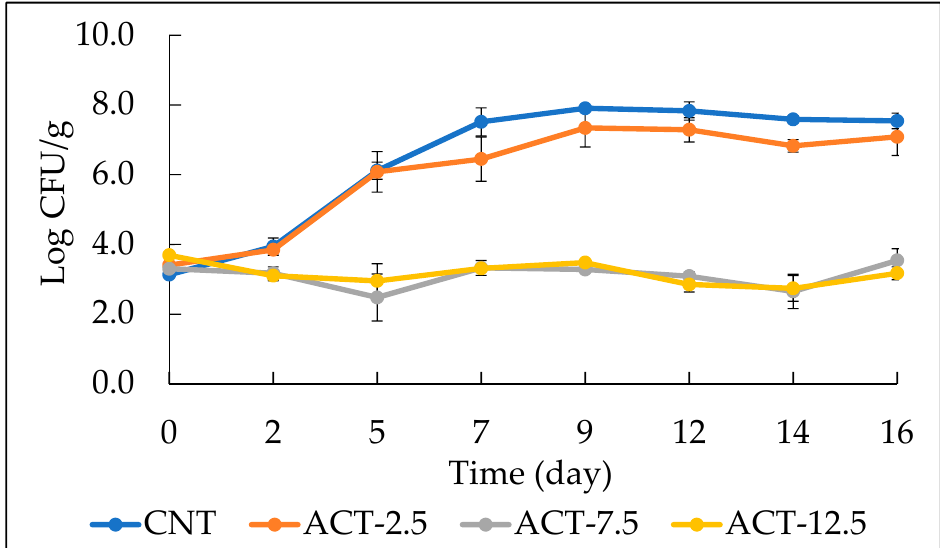
Figure 1. The evolution of Pseudomonas spp. viable cell concentration in fish burgers during 16 days of storage at 4 °C. Data indicate means ± SD. CNT: fish burger without prickly pear powder; ACT-2.5: fish burger enriched with 2.5 g of prickly pear powder; ACT-7.5: fish burger enriched with 7.5 g of prickly pear powder; ACT-12.5: fish burgers enriched with 12.5 g of prickly pear powder.